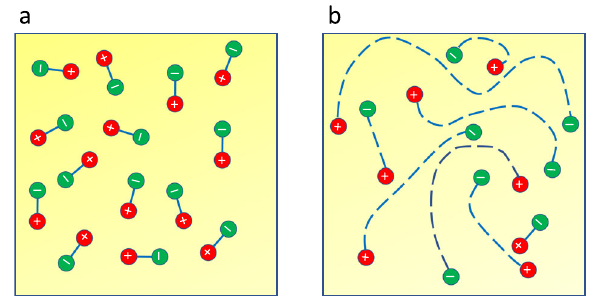
Fig. 1 Magnetic monopole states at low temperatures. a Monopoles are con fi ned into dipoles state by tension of vortices connecting them. b As the vortex tension vanishes, the monopoles at their endpoints become loose free particles that can